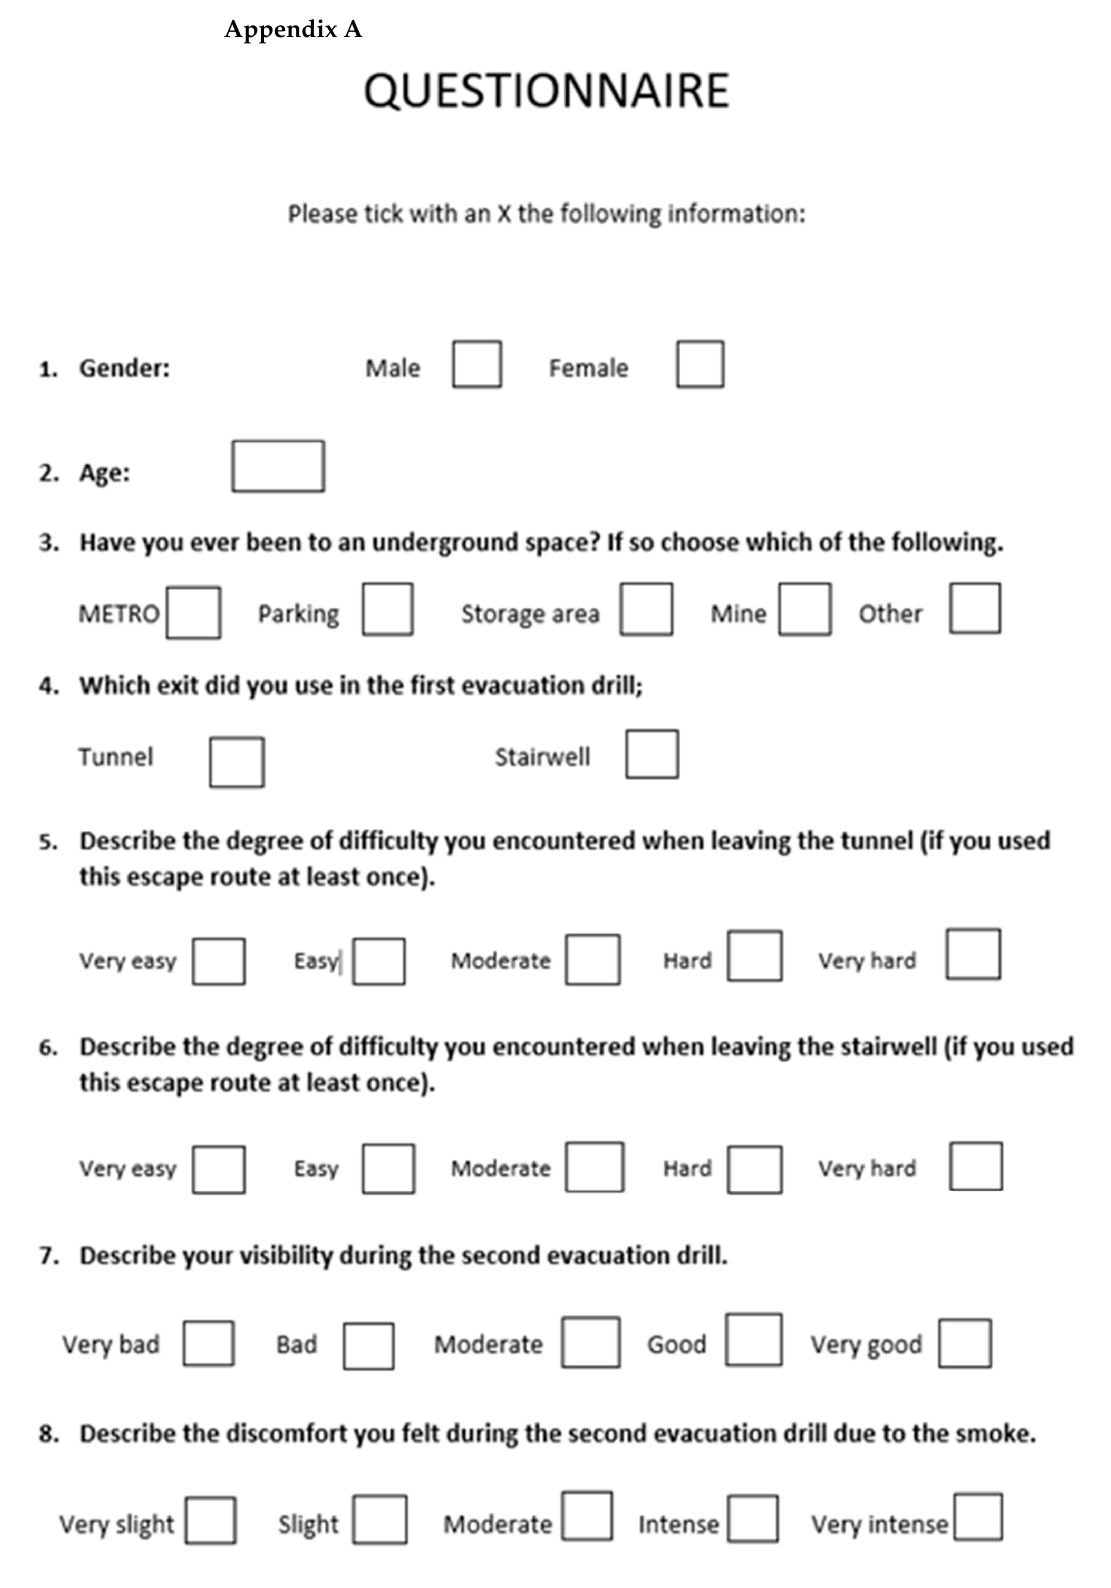
Figure A1. Questionnaire that shared to volunteers. Table A1. First drill results (clear environment).